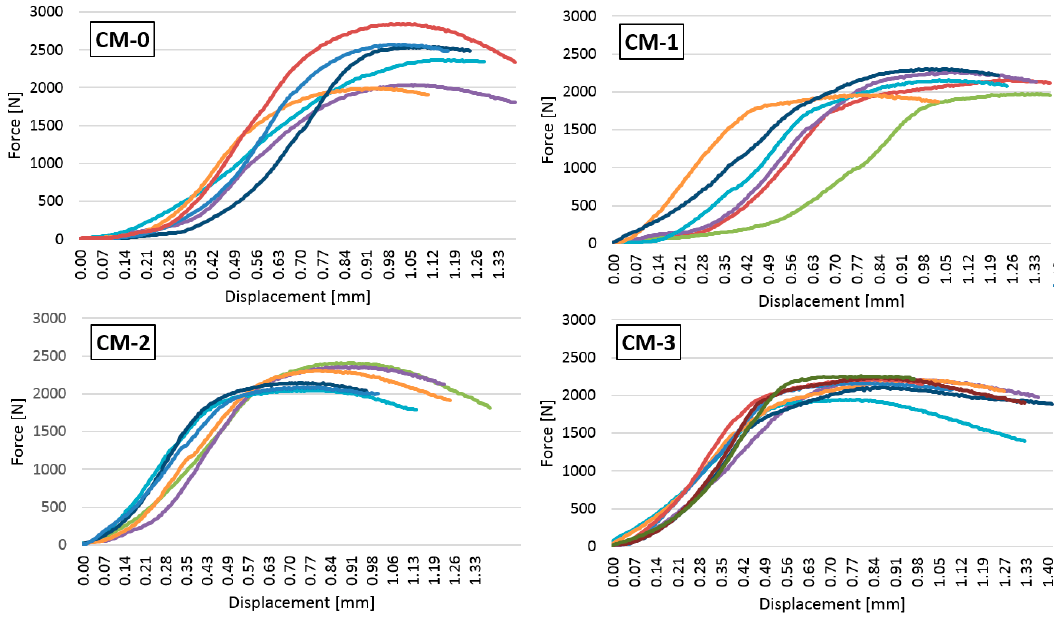
Figure 11. The dependence of the compressive force on the displacement of the press head.